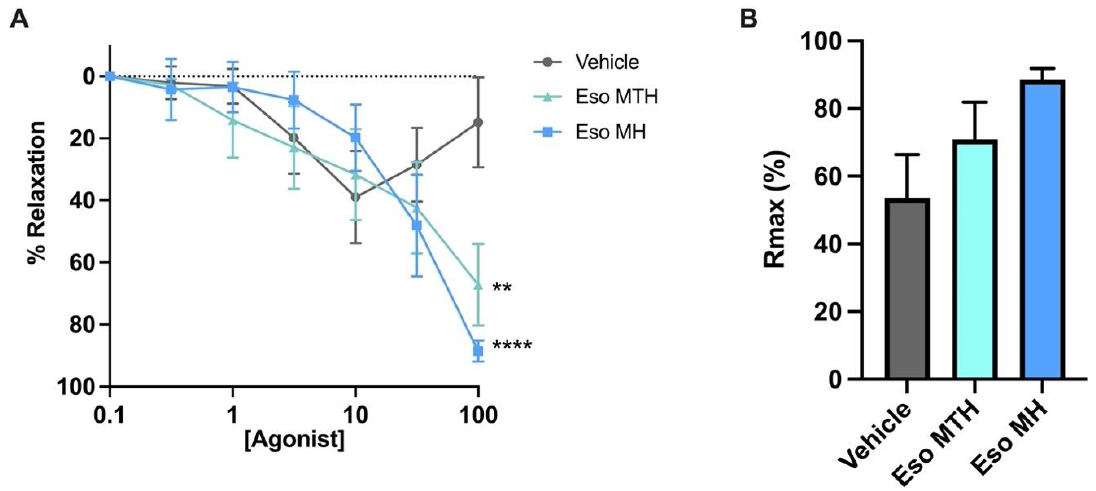
Figure 4. Esomeprazole dilates human omental arteries obtained from normotensive pregnancies. Wire myograph assessment of arterial reactivity following constriction with the vasoconstrictor U44619 (thromboxane agonist), and treatment with 0.1 – 100 μmol/L esomeprazole magnesium trihydrate (Eso MTH) and esomeprazole magnesium hydrate (Eso MH), compared with vehicle ( A , B ). Data presented as percentage of relaxation (% relaxation) following normalisation to the maximum relaxation to bradykinin, demonstrating both Eso MTH and Eso MH significantly relaxed vessels at the highest concentration (100 μmol/L) ( A ). The maximum relaxation induced by Eso MTH or Eso MH show no significant difference to vehicle treated vessels ( B ). Data expressed as mean ± SEM; significance is indicated by the following ** p < 0.01, **** p < 0.0001 ( n = 7). The x -axis is in log10 scale.